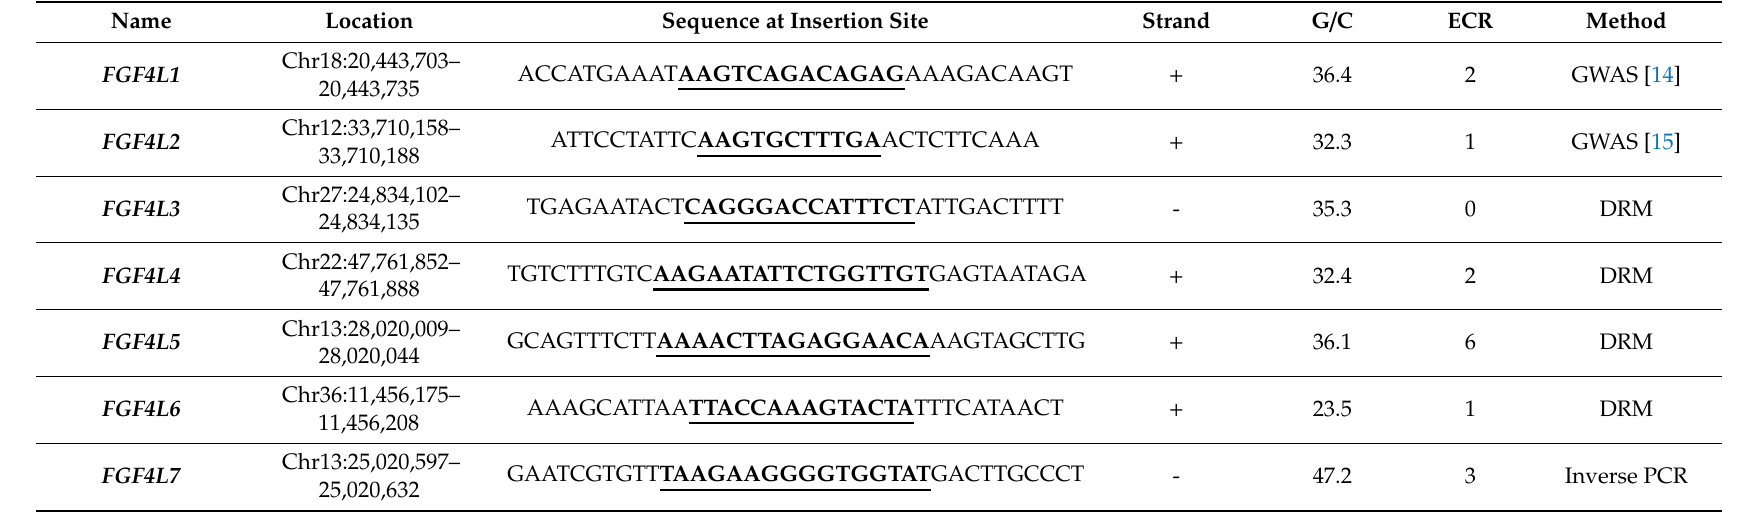
Table 1. Genomic sequence at fibroblast growth factor 4 gene ( FGF4 ) retrocopy insertion sites in canids. Target site duplications (TSDs) are in bold and underlined. Ten bases upstream and downstream from the TSD are included, as well as the strand orientation of the retrocopy, G / C content of the region, and evolutionarily conserved elements (ECR) within 2.5 kb of the insertion site. FGF4 retrocopies were identified by GWAS, discordant read mapping (DRM), and inverse